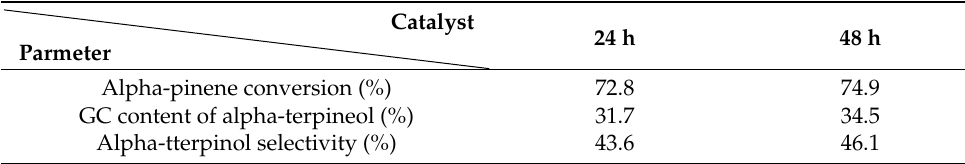
Table 2. Catalytic effects of increasing the amount of acetic acid and decreasing the amount of citric acid.